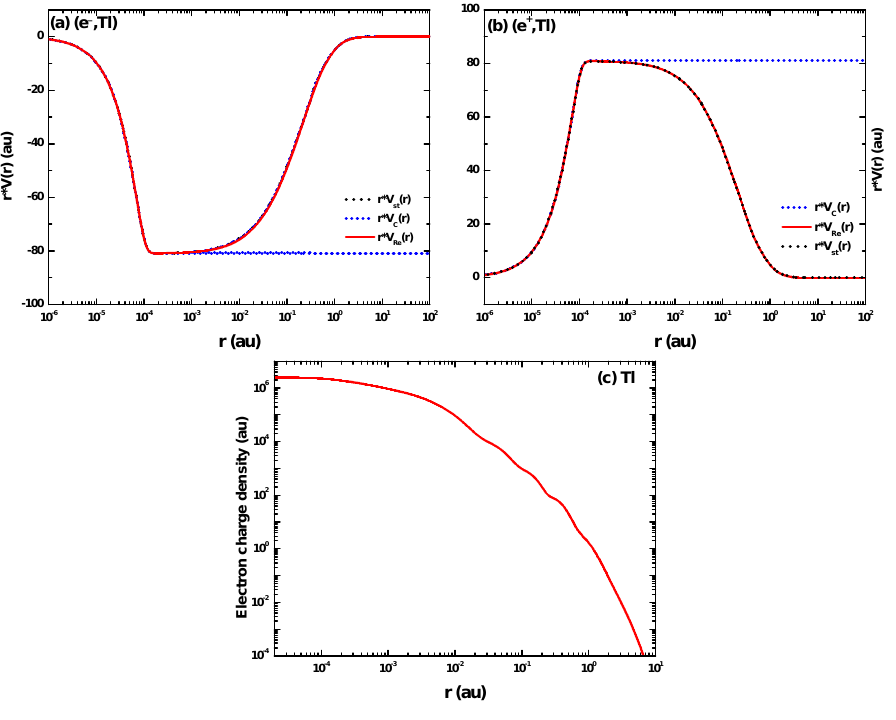
Figure 1. Radial distance r times the radial distribution of the potential V ( r ) for ( a ) e − − Tl and ( b ) e + − Tl scattering. The red solid line represents the real potential, and the dotted (black) and dotted (blue) lines are, respectively, the static and Coulomb potentials. ( c ) shows the electronic charge density of Tl VS radial distance from the